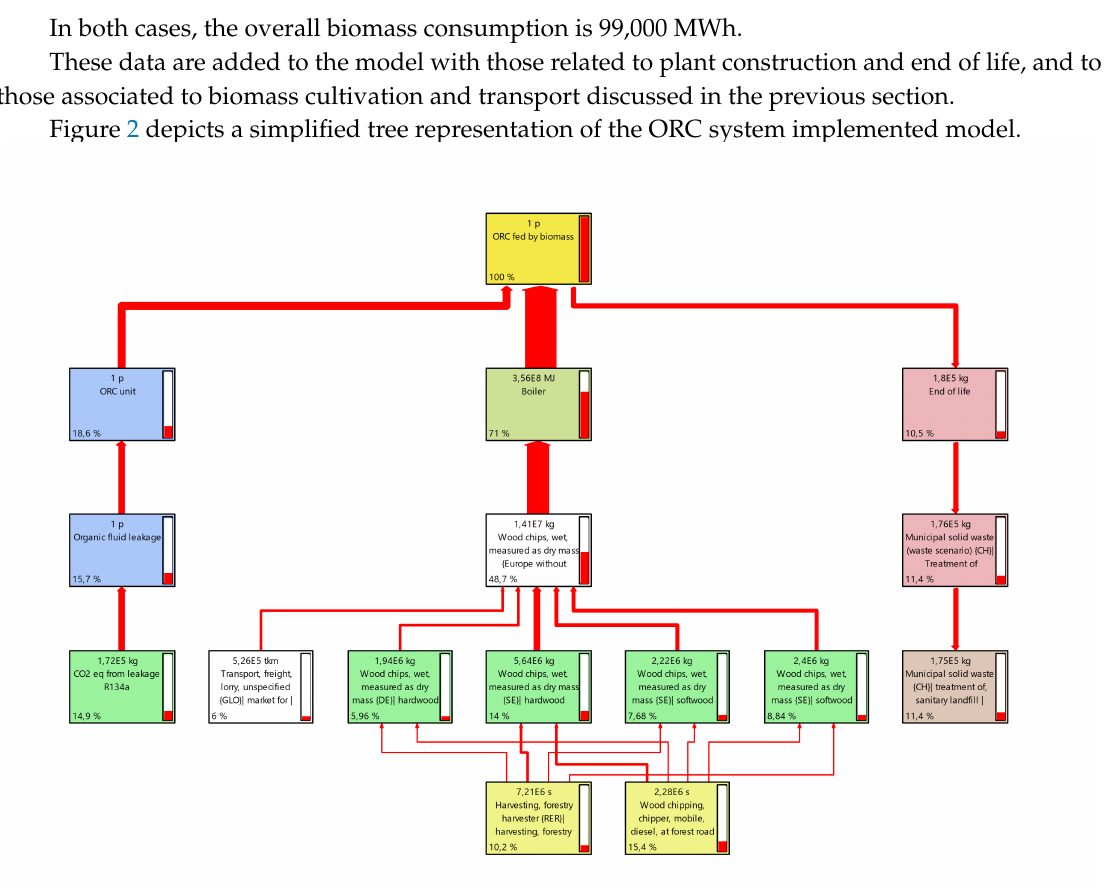
Figure 2. Simplified tree representation of the system in the lifecycle assessment. Percentages and lines refer to CO 2,eq